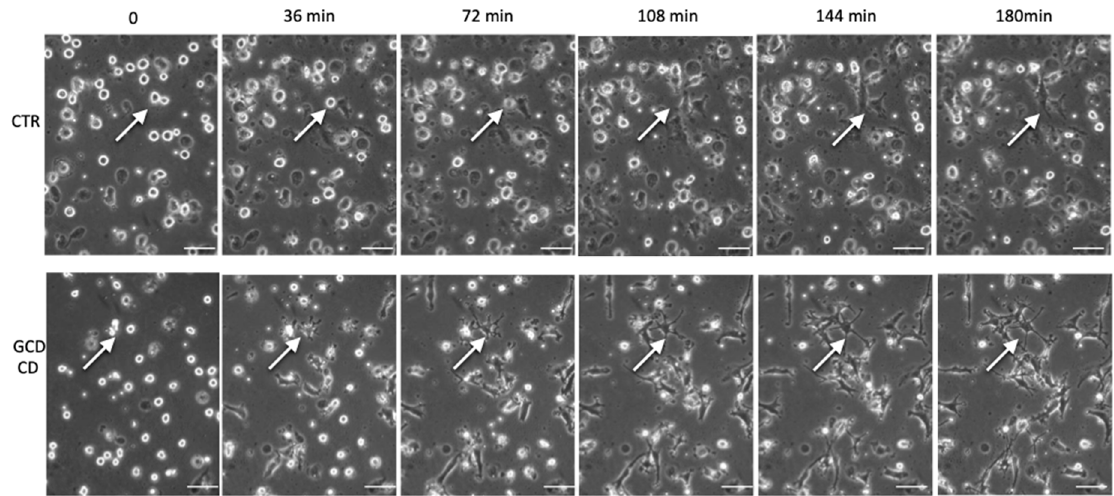
Figure 4. Spreading ability of fibronectin-adhering DCs. DCs from three active celiac patients (GCD-CD) and from three controls were seeded on wells pre-coated with fibronectin at a density of 2.5 × 10 5 cells/mL, and their spreading properties were recorded live for 3 h to observe dendrite formation. Fifty cells in each frame were followed over time for a total of 200 DCs per patient. One picture every 36 min of the movie is shown, starting from T0 (the time when DCs were seeded in the well) until T180 (the time when the film was stopped). Images from a representative CD patient and a representative control out of at least three subjects per group are shown. White arrows indicate the same cells in each panel. Scale bar = 20 µm.